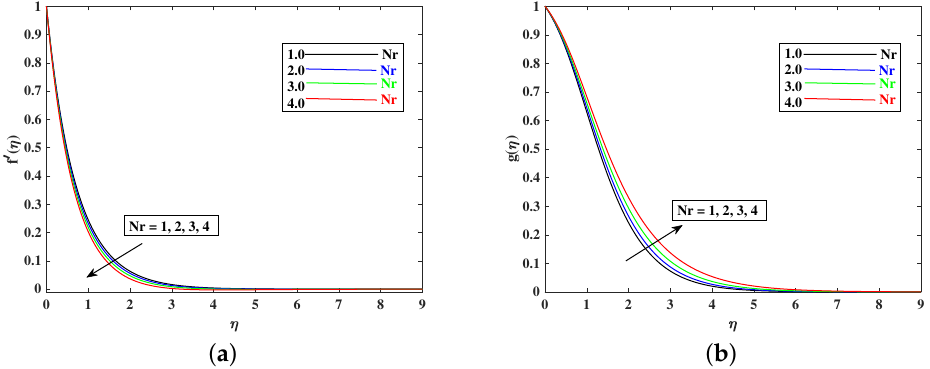
Figure 5. Variation of Nr to influence the velocity and temperature profile. ( a ) Variation of Nr to influence the velocity. ( b ) Variation of Nr to influence the temperature.